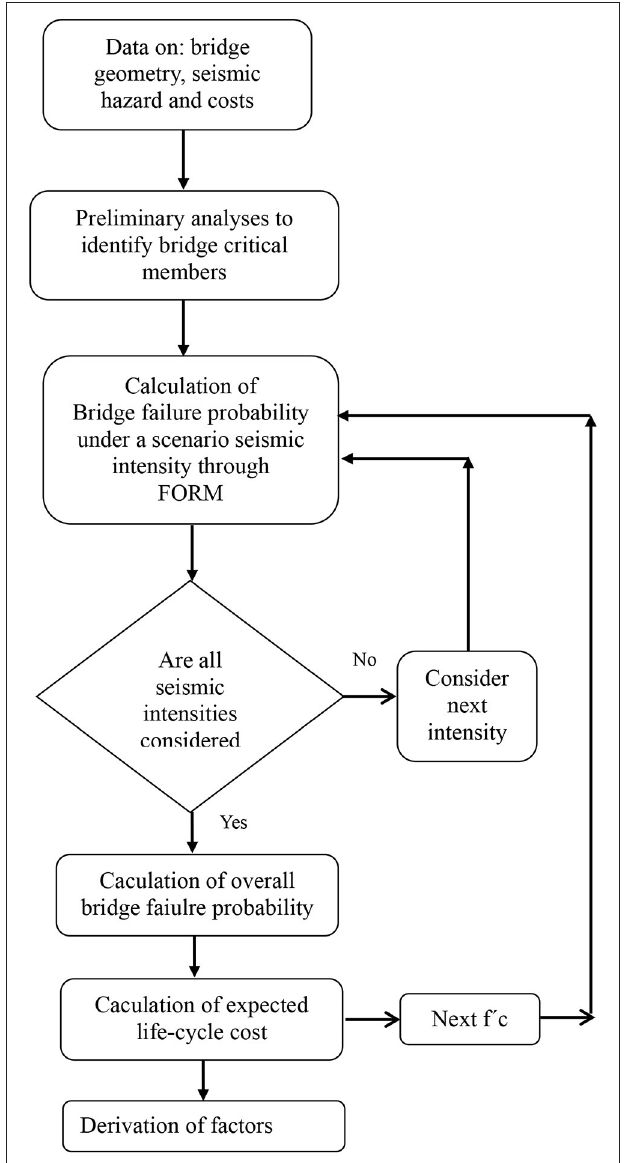
FIGURE 2 | Interaction diagram for critical pier with acting and resisting forces.